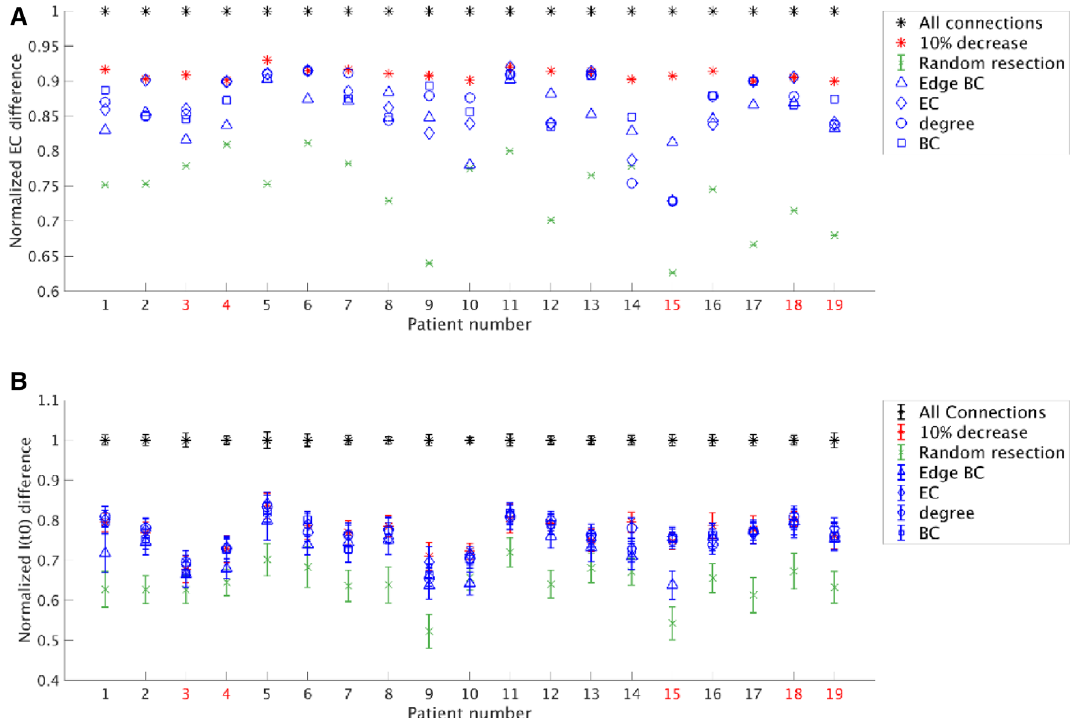
Figure 4. Comparison of various resection strategies for all patients as measured by the normalized EC difference and the normalized difference in I(t 0 ), respectively in panels ( A ) and ( B ). ( A ) The normalized EC difference for a resection is defined as the ratio between the EC difference for the optimal resection and the EC difference for a full resection. Removing all connections resulted in the largest EC difference (100%, black stars). A 10% decrease in the EC difference was accepted (red stars), using simulated annealing to optimize which connections to remove, and thereby sparing connections. This method performed better than the average of 100 random resections (green cross with standard deviation), using the same number of removed connections chosen randomly from the candidate connections. For comparison, the same number of removed connections were also chosen using network measures: edge BC (blue triangles), EC (blue diamonds), degree (blue circles), and BC (blue squares). The three latter measures were based on the property of the connected node outside the SOZ. ( B ) The normalized I(t 0 ) difference for a resection is defined as the difference between I(t 0 ) before and after the resection, normalized by this difference for a full resection. Similarly to the EC difference, removing all connections (black stars) resulted in 100% decrease of I(t 0 ). The optimal resection given by the surrogate model (red stars) performed marginally better than the resections based on network metrics (blue markers) for some patients. Random resections (green markers) performed the worst. All values correspond to the same resections used in panel A . The error bars were calculated as in Fig. 3. The not seizure-free patients are marked in red in both